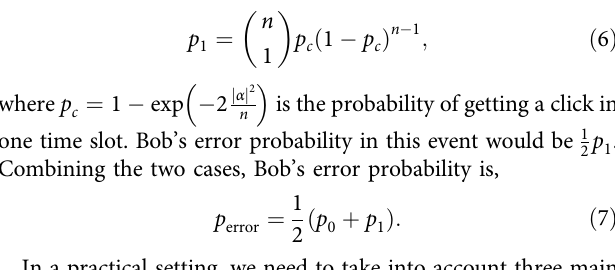
value. We have also included in the graph the classical lower bound described previously and we have additionally considered the case where Bob only outputs the parity outcome when he he obtains at least two single clicks in the experimental run, which we call the post-selected